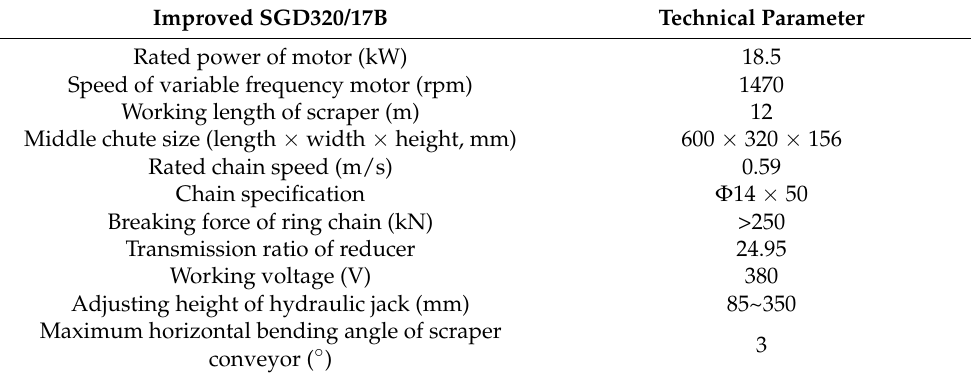
Table 1. Technical parameters of the test bench.